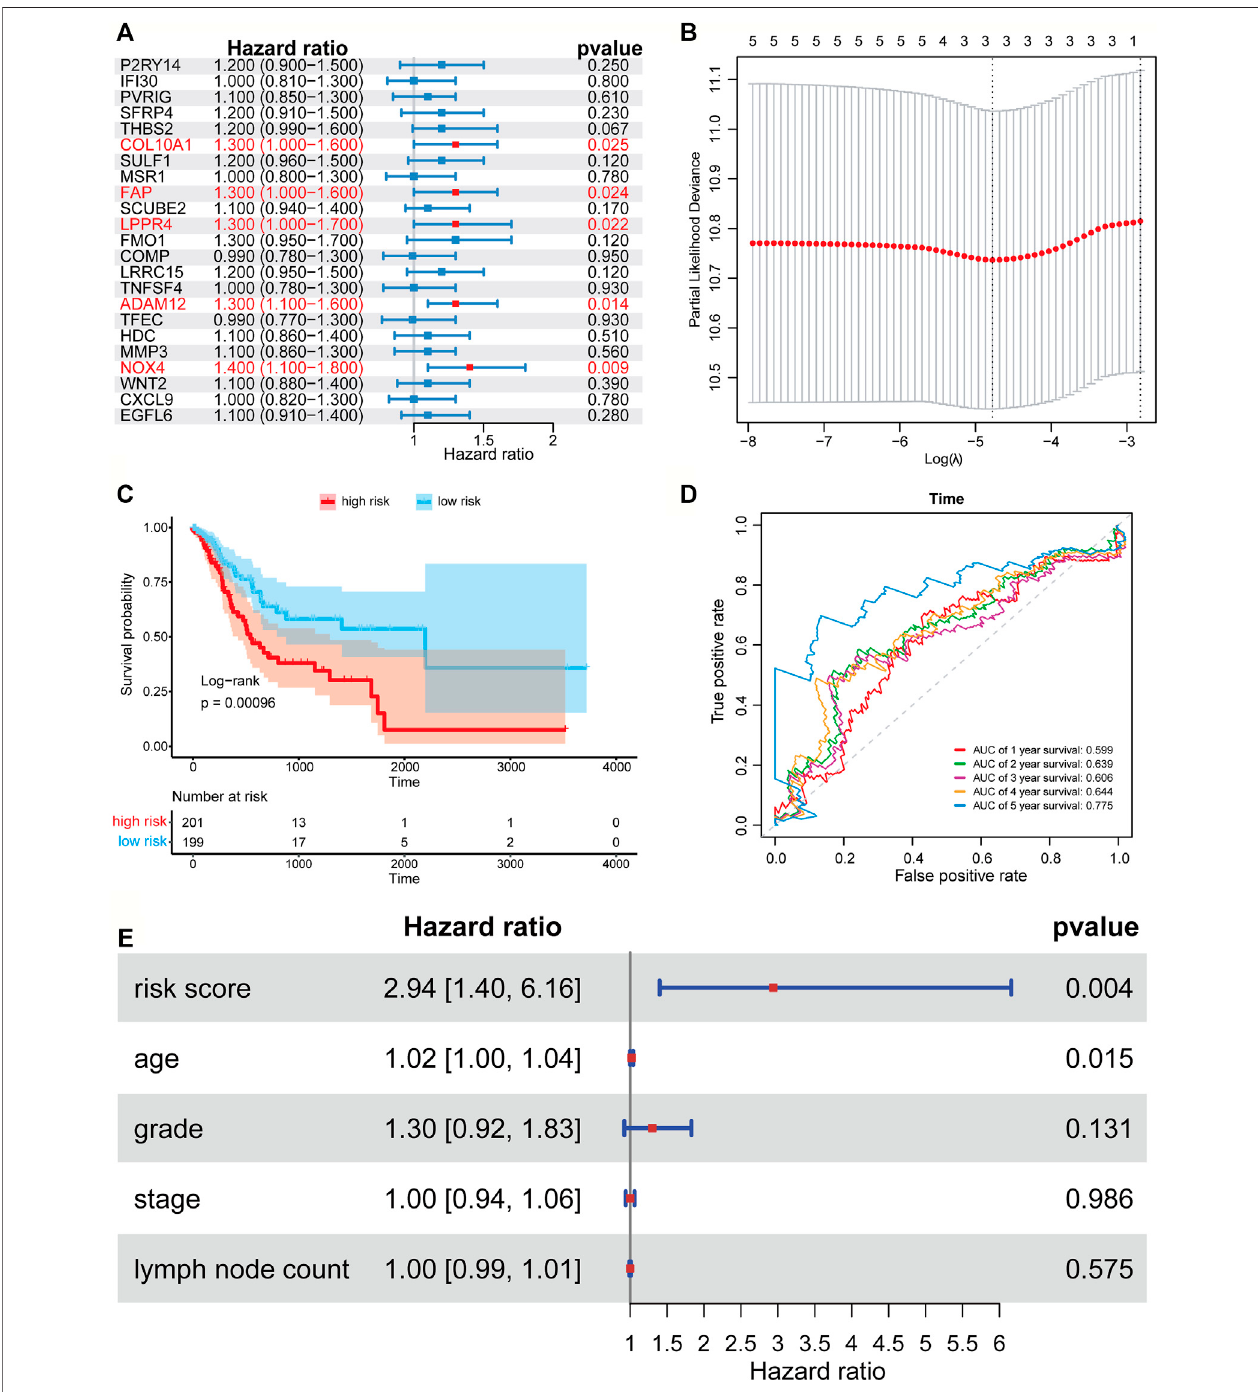
FIGURE 3 | Forest plots, Kaplan-Meier plots, and time-dependent ROC curves of the risk score model. (A) Forest plots of univariate Cox proportional hazards regression analysis identi fi ed fi ve prognostic genes related to the TME. (B) LASSO regression analysis showed the partial likelihood deviation curve of the minimum numbergenescorrespondingtothecovariatesusedformultivariateCoxanalysis. (C) TheKaplan-Meiercurvesofthehigh-riskandlow-riskgroup. (D) ROCcurveschart of the risk score model predicting the 1 – 5 years survival rate. (E) Multivariate Cox regression analysis of risk score and other prognostic factors.